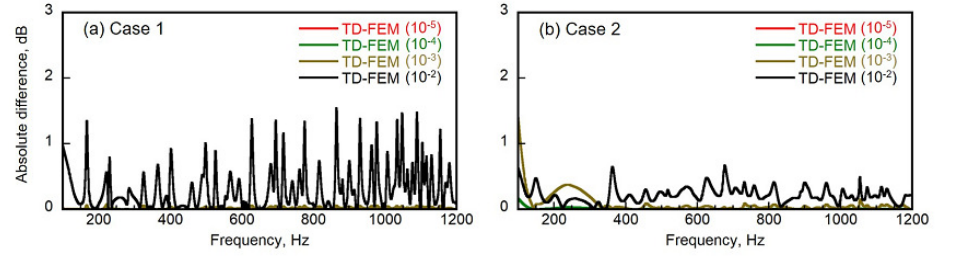
Figure A2. Absolute differences with respect to mean SPL in each tolerance condition from the sufficiently accurate condition of 10 − 6 in ( a ) Case 1 and ( b ) Case 2, where the values in parentheses following TD-FEM represent the convergence tolerance for CR